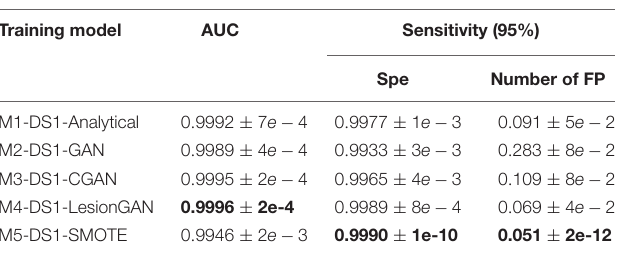
(AUC = 0.9987), while M5-DS1-SMOTE had the lowest performance (AUC =